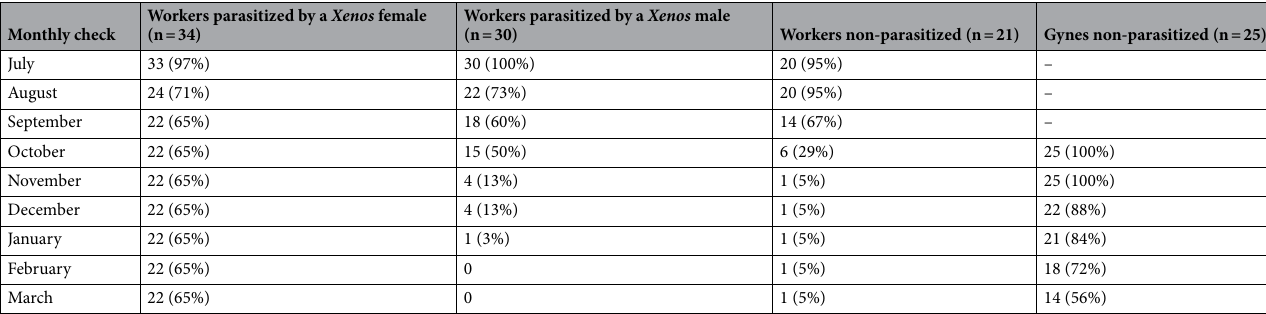
Table 1. Monthly number of live wasps (% survival rate) as a function of their caste and parasitic